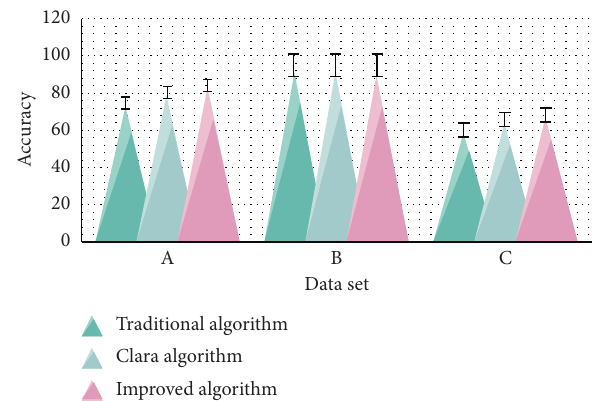
Figure 7: Accuracy of clustering results of different algorithms in different